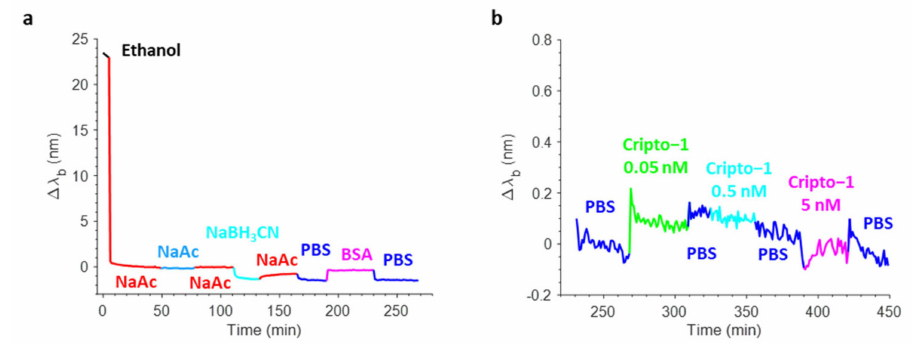
Figure 9. Real-time sensorgram showing the variations in the barycentric wavelength of the resonance of an OFMT during the biofunctionalization phase without the oriented 1B4 antibody ( a ). Probe immersion at increasing concentrations of Cripto-1 in PBS in the range of 0.05 and 0.5 nM ( b